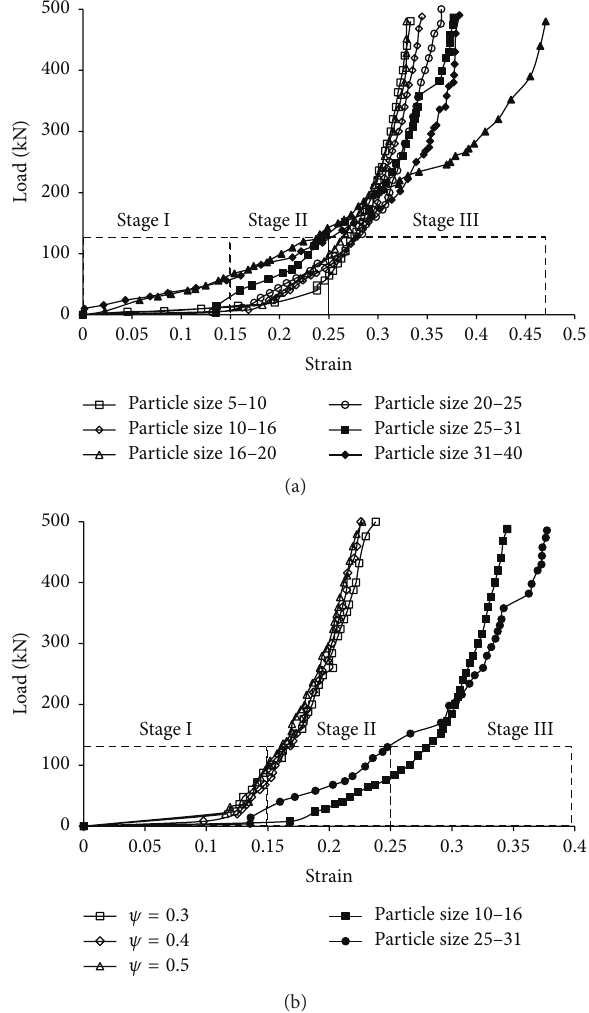
Figure 7: (a) Material compaction test machine; (b) data acquisition system; (c) hydraulic pressure system.